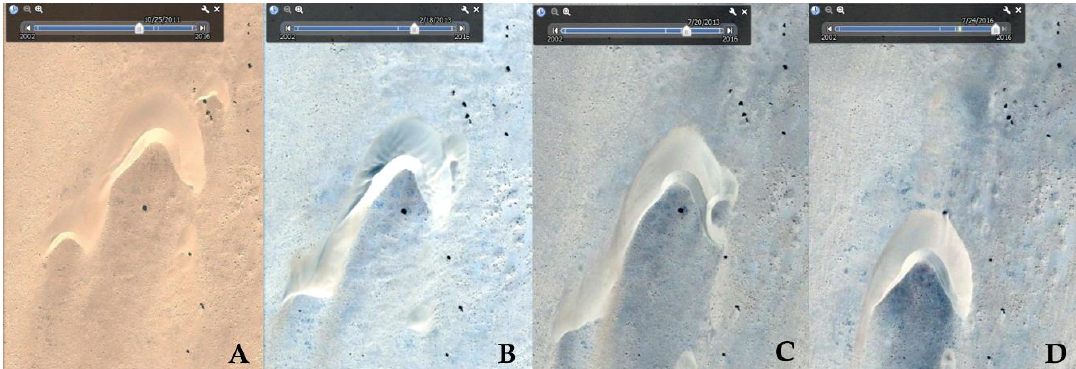
Figure 9. Example of the merging and splitting phenomena that can occur in dune fields when smaller dunes reach larger dunes. Barchan dunes are characterized as conserving their shape while moving, as illustrated in the images available in Google Earth over the dunes located in the WSM site (i.e., 21.501 North, 16.726 West). Images sorted in acquisition time from left to right. ( A ) acquired on 25/10/2011; ( B ) on 18/02/2013; ( C ) on 20/07/2013; and ( D ) on 24/07/2016.